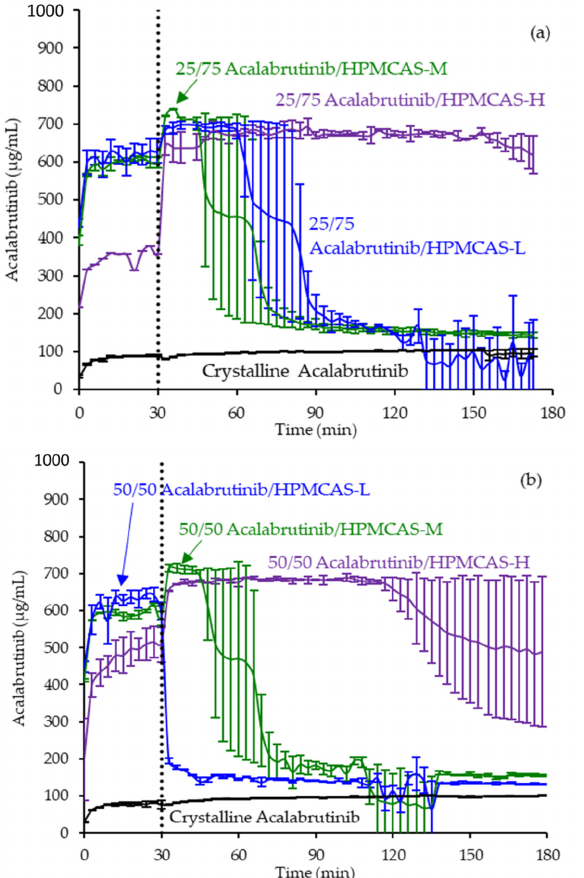
Figure 3. Dissolution profiles of ASD intermediates in a gastric to intestinal transfer dissolution test using a Pion µDiss Profiler under conditions simulating fasted dogs treated with an ARA (gastric pH 6) (curves represent average values whereas error bars represent range, n = 2). Panel ( a ) 25 wt % drug loading ASDs. Panel ( b ) 50 wt % drug loading ASDs.